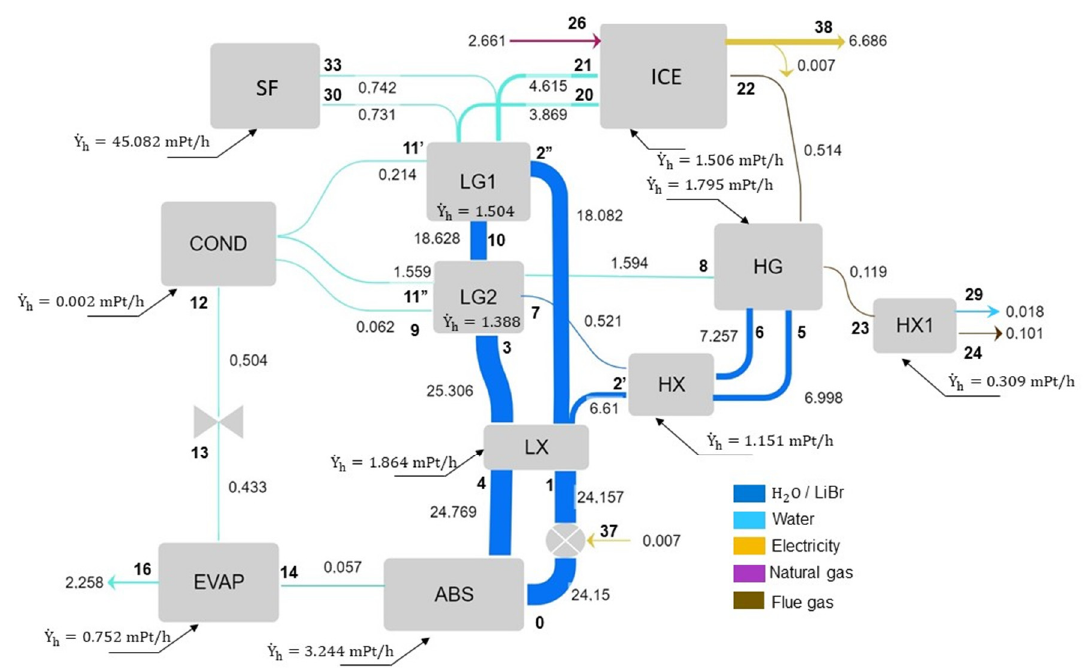
Figure 4. Sankey diagram of environmental impact rates in trigeneration system. Values in mPt/s. Table 6. Exergoenvironmental